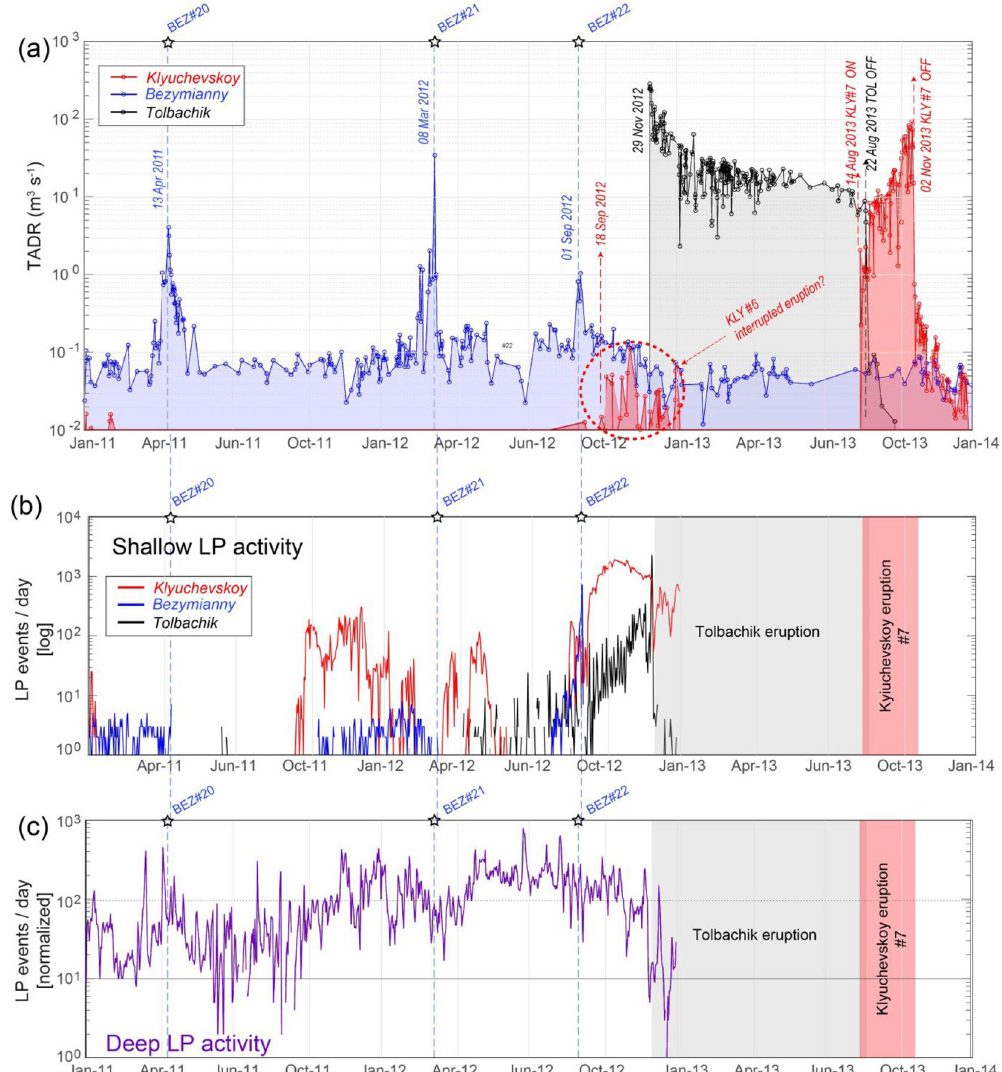
Figure 6. Reactivation of Tolbachik and responses at other volcanoes. ( a ) Stacked TADR time-series for Klyuchevskoy, Bezymianny, and Tolbachik between 2011 and 2014. ( b ) Shallow LP seismicity (normalized number of events per day) below the Klyuchevskoy, Bezymianny, and Tolbachik during the same period (modified from Shapiro et al. 2017); ( c ) Deep LP seismicity below the KVG (seismic data modified from Shapiro et al. 2017); (refer to the color version of the figure). Time series generated using MATLAB software (www. mathw orks.